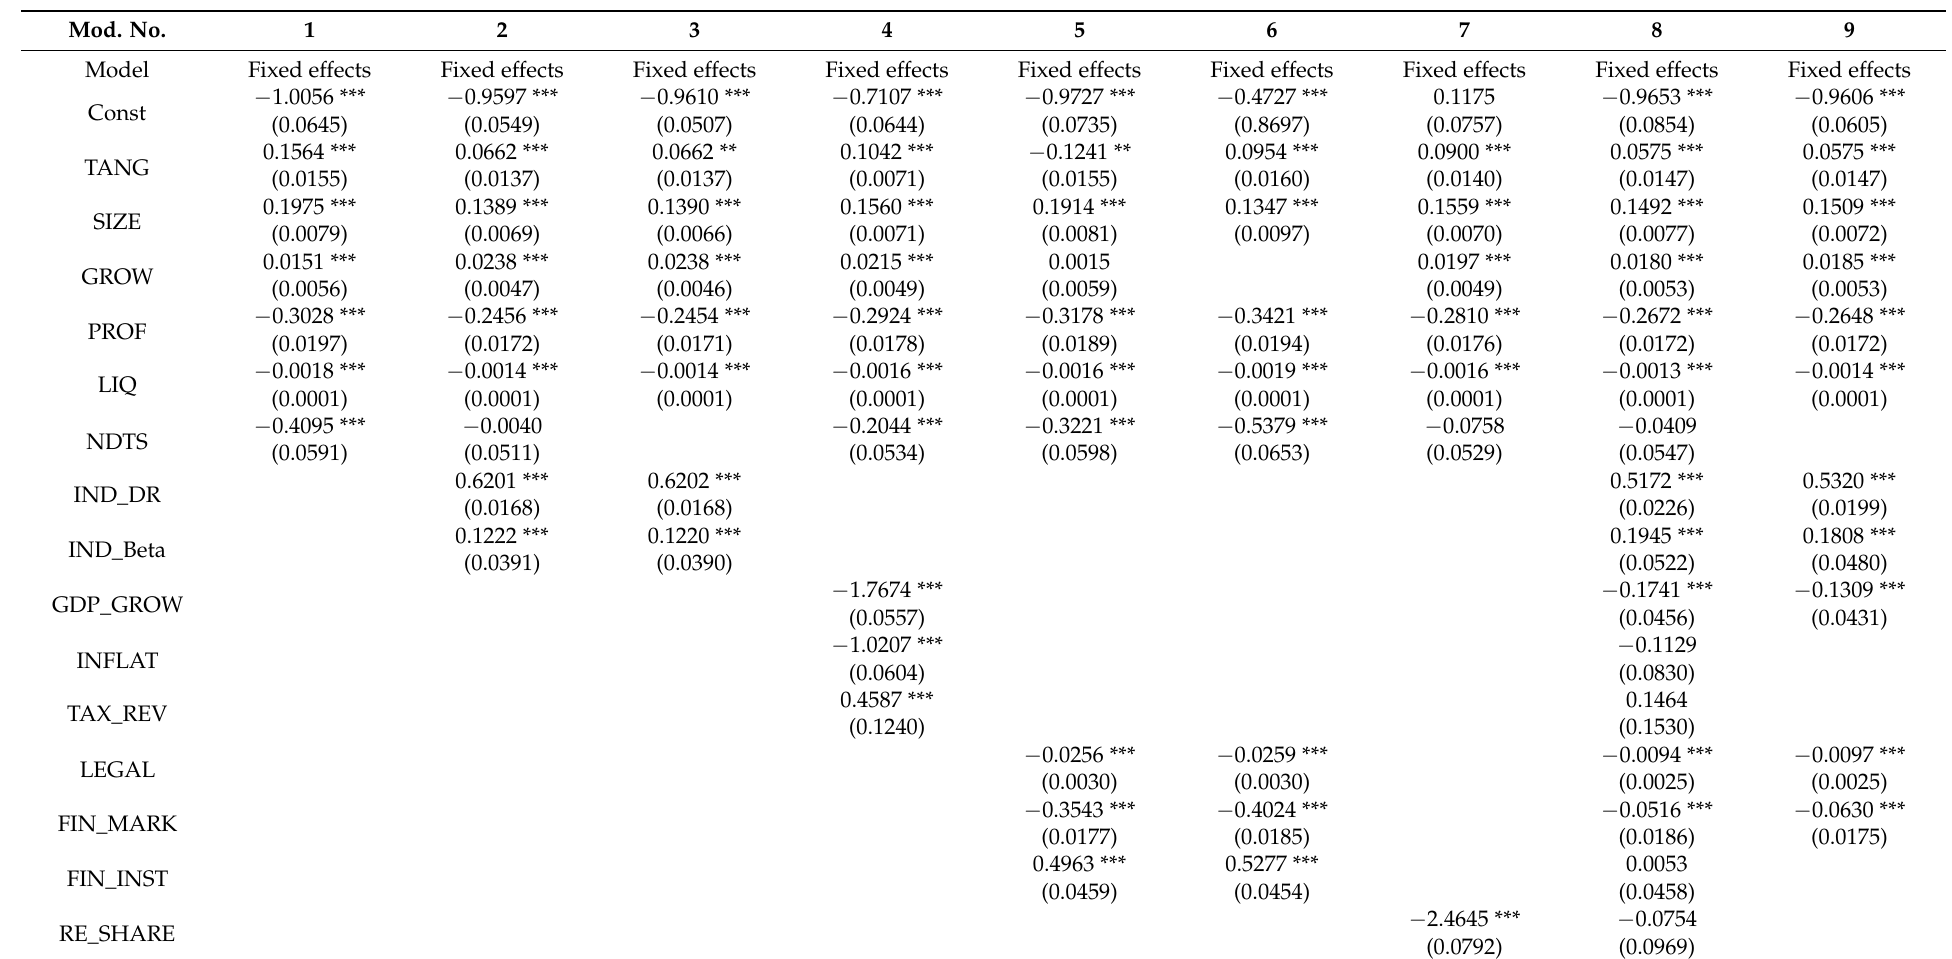
Table A2. Results of model